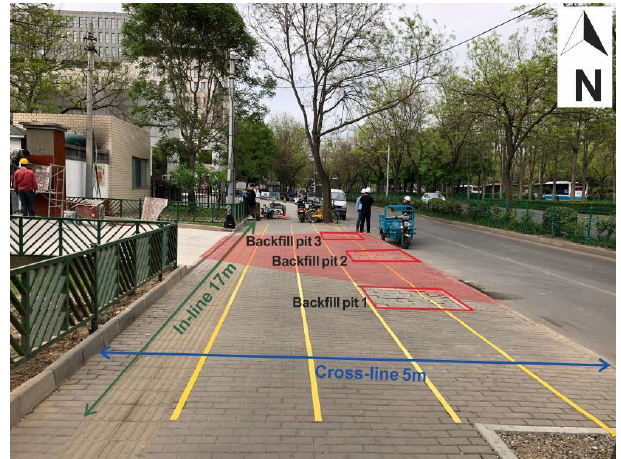
Figure 1. Overview of the experimental area. Table 1. TLFC 3D GPR data acquisition parameters.